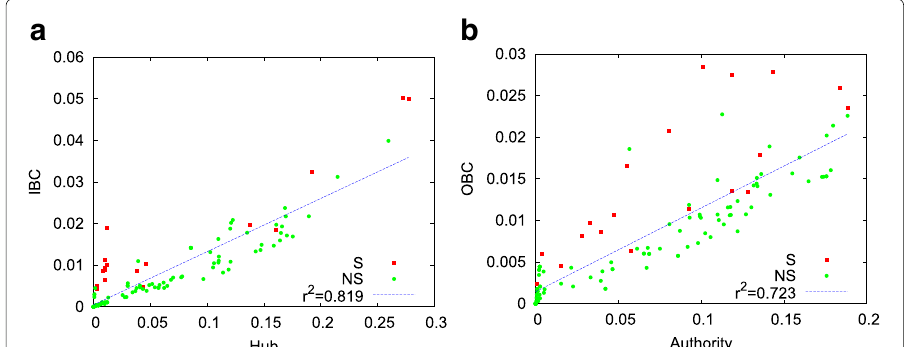
Fig. 7 IBC a and OBC b of each node in the same food web as in Fig. 6 are plotted against Hub score and Authority score, respectively. The red squares represent nodes whose IBC or OBC are judged to be significantly high in Fig. 6. The green points are the other non-significant nodes. Dotted lines are the best linear fits. The coefficients of determination are